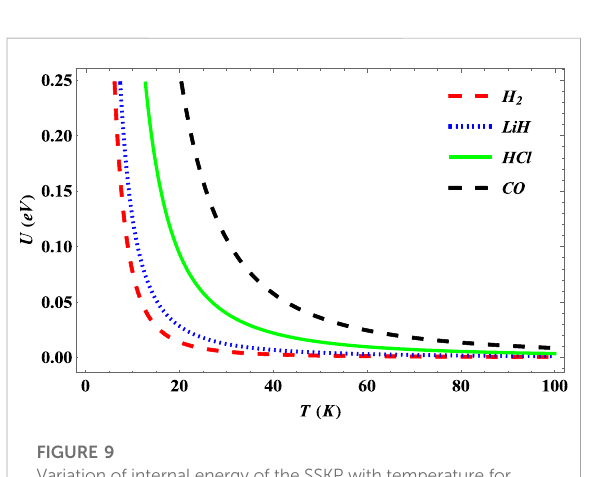
FIGURE 9 Variation of internal energy of the SSKP with temperature for different diatomic molecule systems with n = 2 and l = 1.